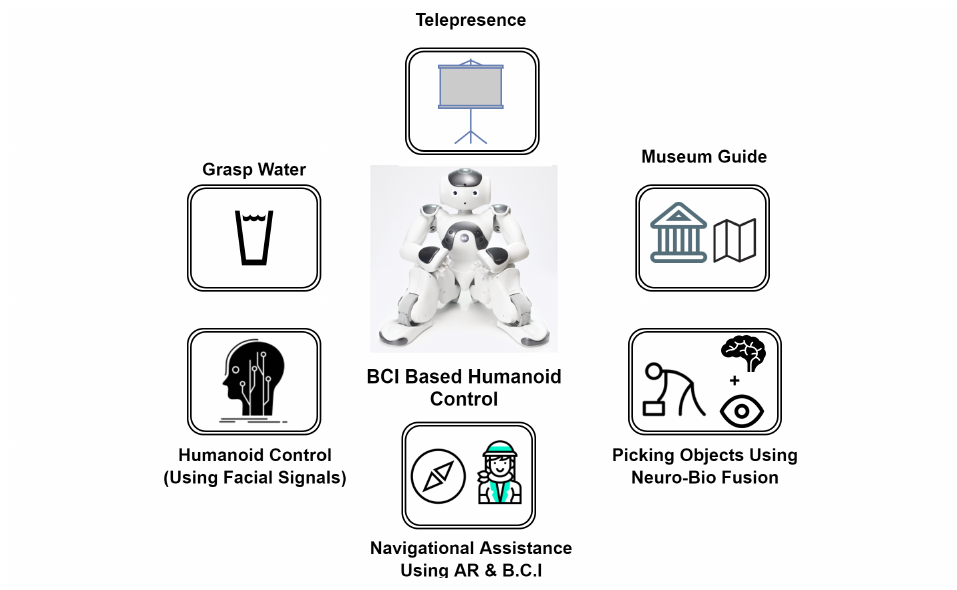
Figure 4. Overview of